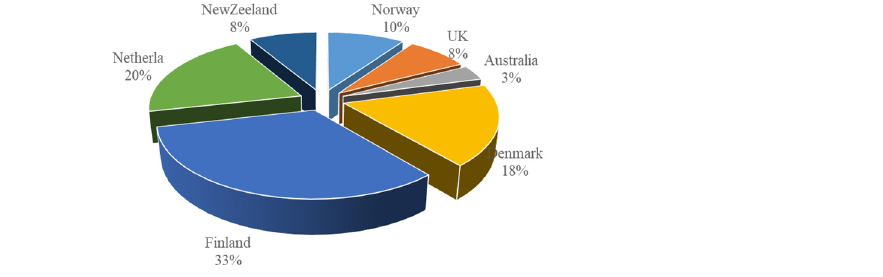
Figure 10. Reduction in CO 2 in tonnes per country and year with EPA (adapted with permission from Ref. [34]. 2021. Díaz-Ruiz-Navamuel, E.).